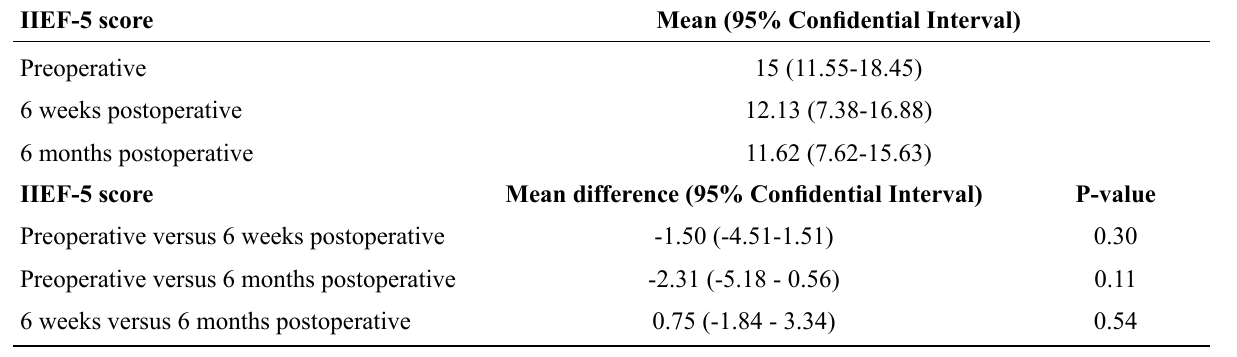
Table 2 - Results IIEF-5 scores.